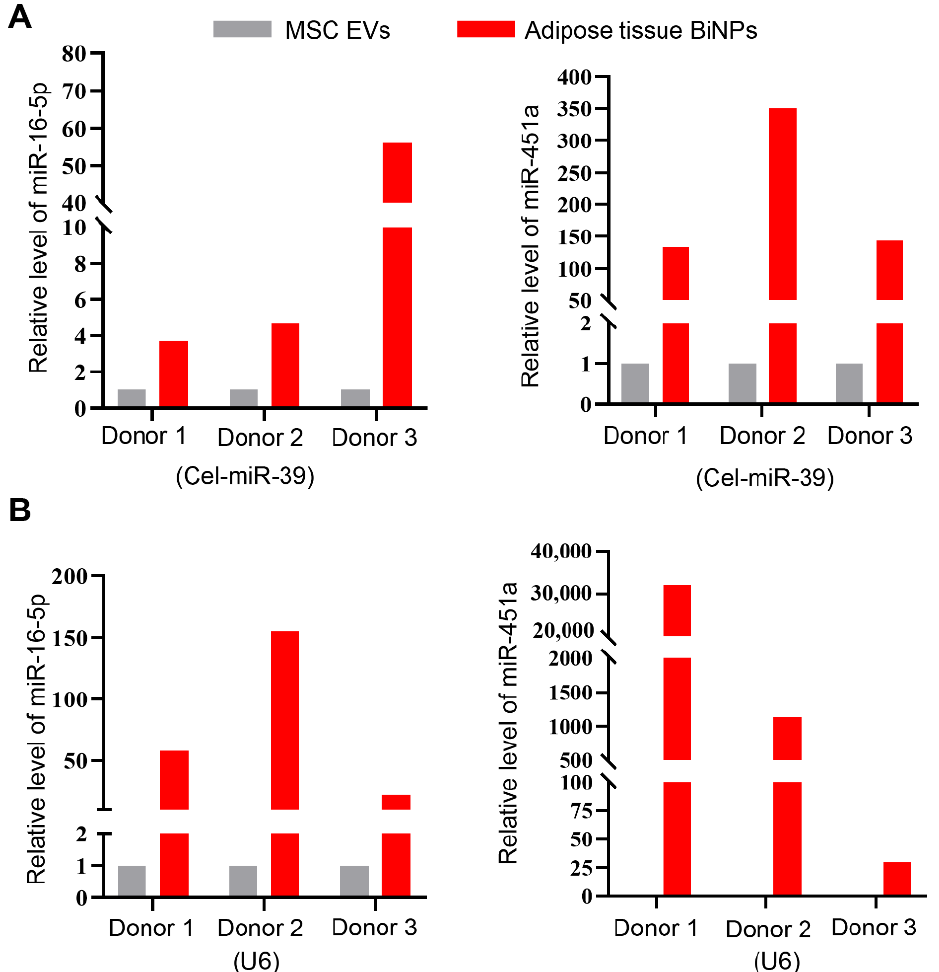
Figure 2 . Quantitative real-time polymerase chain reaction (qRT-PCR) levels of microRNAs (miR)- 16-5p and miR-451a in three donor-matched adipose-derived MSC EVs and adipose tissue BiNPs normalized for Cel-miR-39 ( A ) and U6 ( B ).